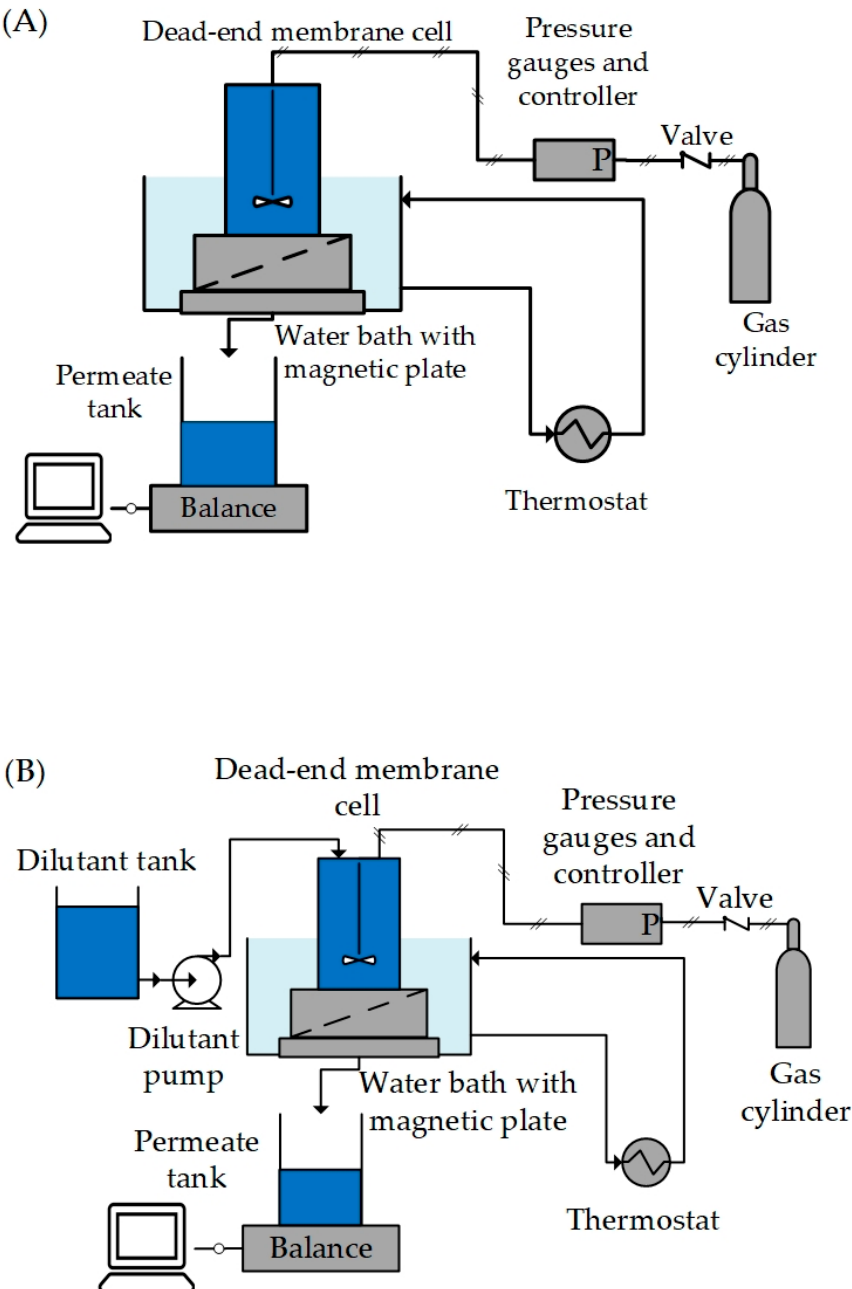
Figure 1. Experimental setup for membrane screening, discontinuous diafiltration ( A ), and semi-continuous diafiltration experiments ( B ). It consisted of a dead-end membrane module with an active membrane area of 54 cm 2 , placed on a magnetic stirrer in a temperature-controlled water bath.